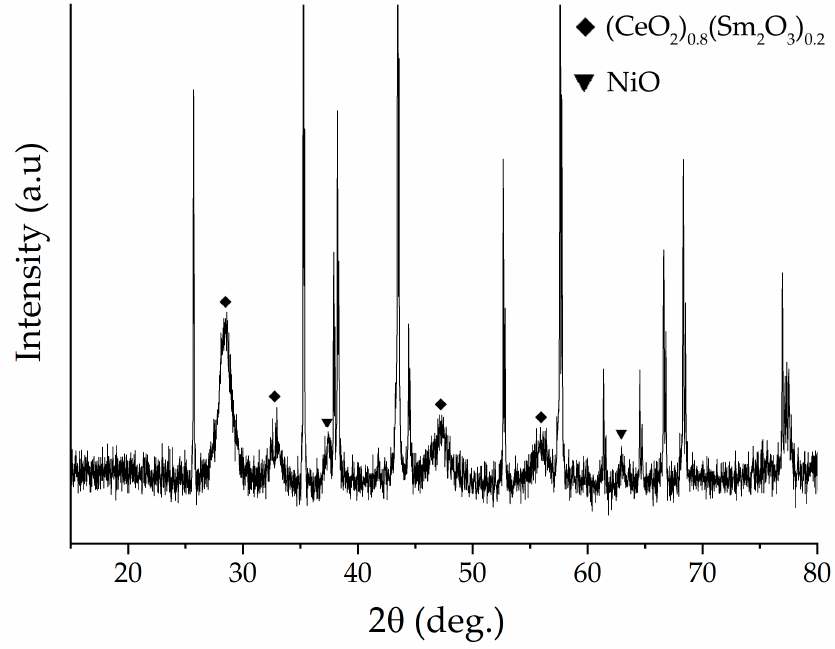
Figure 6. XRD pattern of the NiO–SDC composite film printed on an Al 2 O 3 substrate surface.